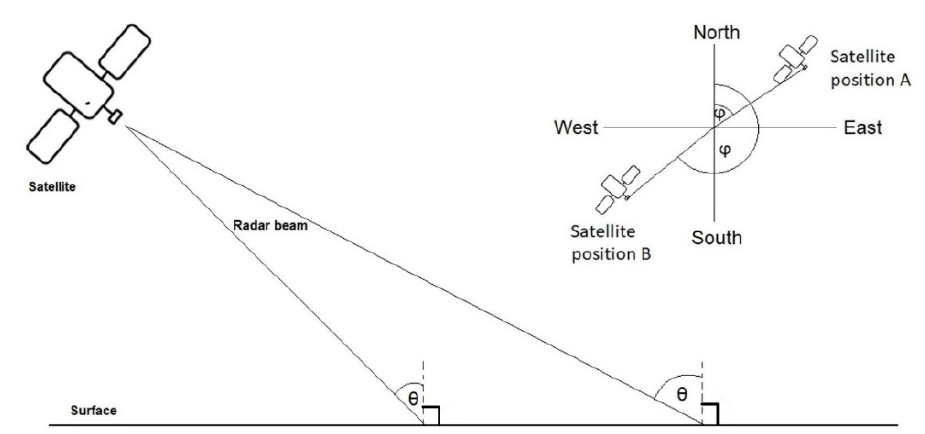
Figure 7. Illustration of vertical incident angle θ and the horizontal azimuth angle ϕ .